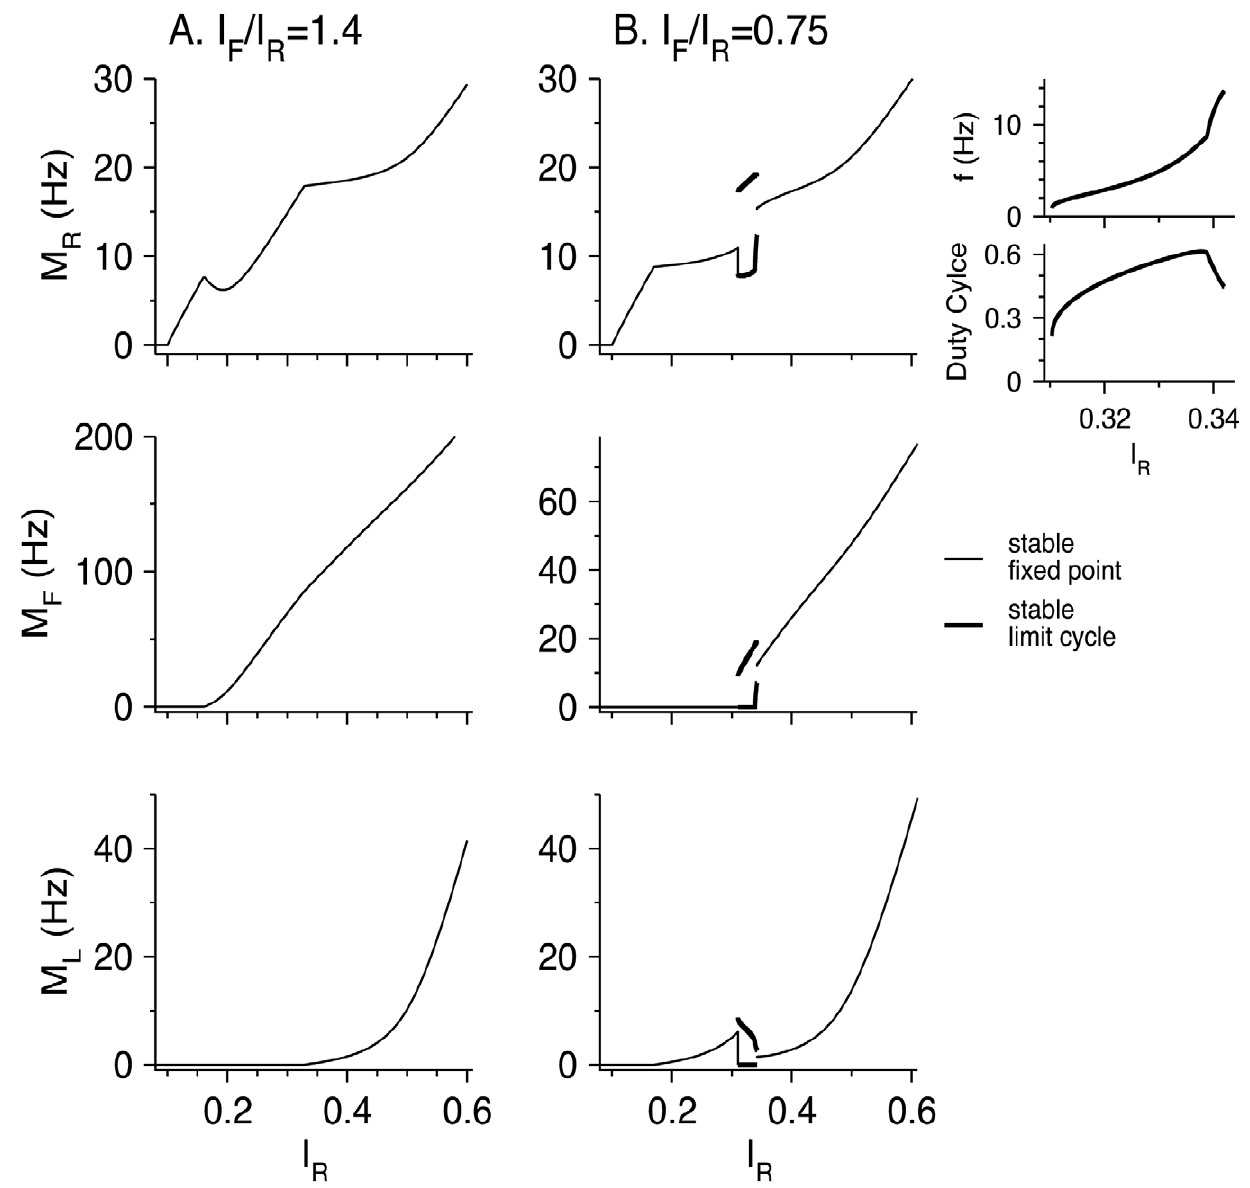
Figure 10. Steady-state response of the RS-LTS-FS network constant inputs to the RS and FS neurons with fixed I F / I R . Parameters are listed in Table 2. In the two left columns, values of M R (top panels), M F (middle panels) and M L (bottom panels) are plotted as a function of I R . Thin solid lines: stable fixed points; thick solid lines: minimum and maximum of M on stable limit cycles (slow-oscillations states). (A) I F =1.4 I R (dotted line in Figure 9). (B) I F =0.75 I R (dashed line in Figure 9). The small panels on the right display the oscillation frequency f and the duty cycle of the oscillations (the ratio between the time interval during which RS neurons are in the more active state and the oscillation time period).